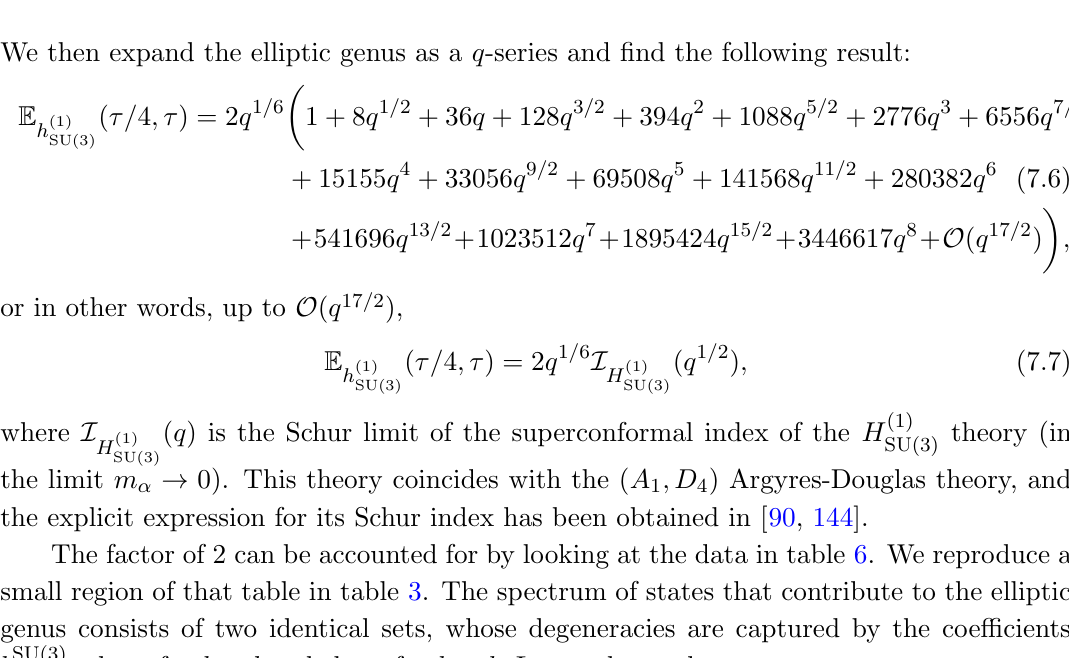
Table 3 . Expansion coe(cid:14)cients b SU(3)